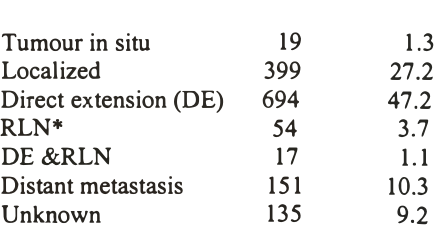
Table 4: Distribution of Leukaemia cases